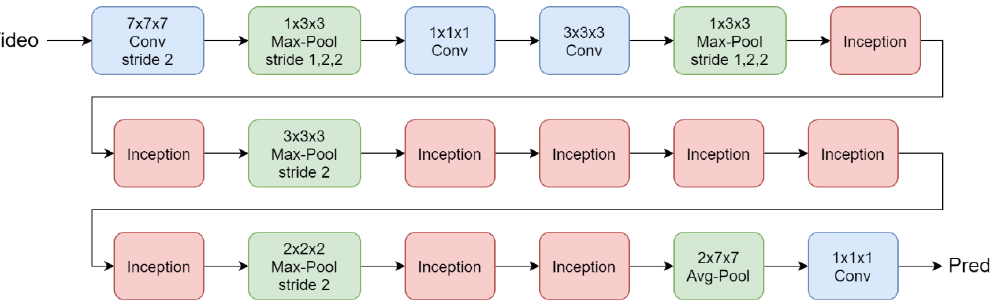
Figure 6. Inflated 3D (I3D) network architecture [20] © 2020 IEEE.